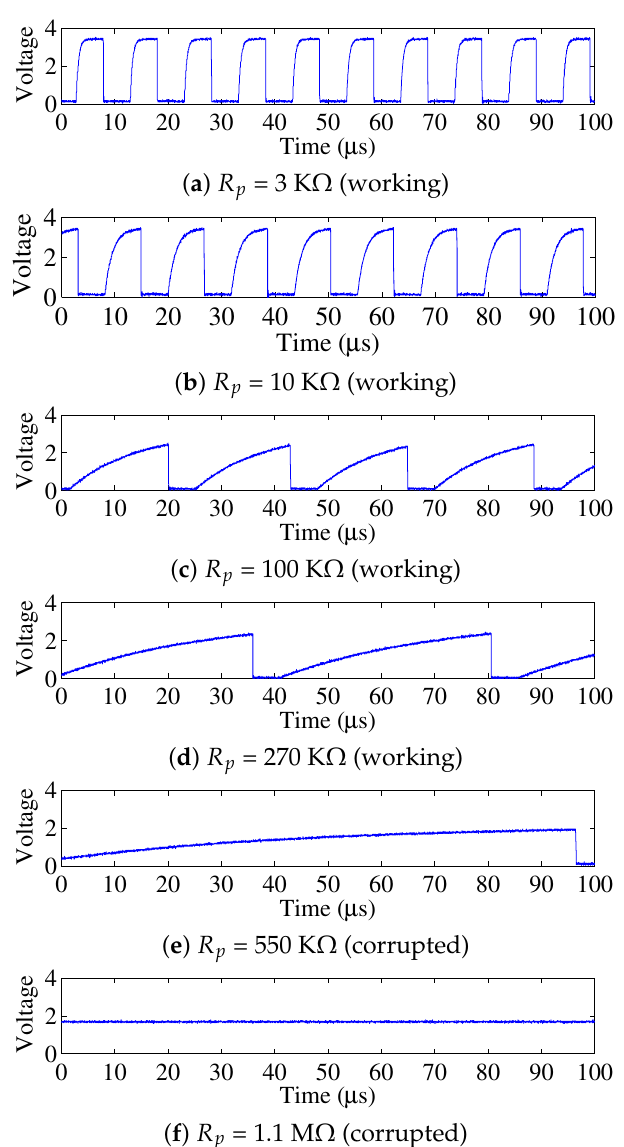
Figure 7. SCL waveform (before the waveshaper) over different pull-up resistances. I 2 C communica- tion works in case of ( a – d ), while the communication is corrupted in case ( e , f